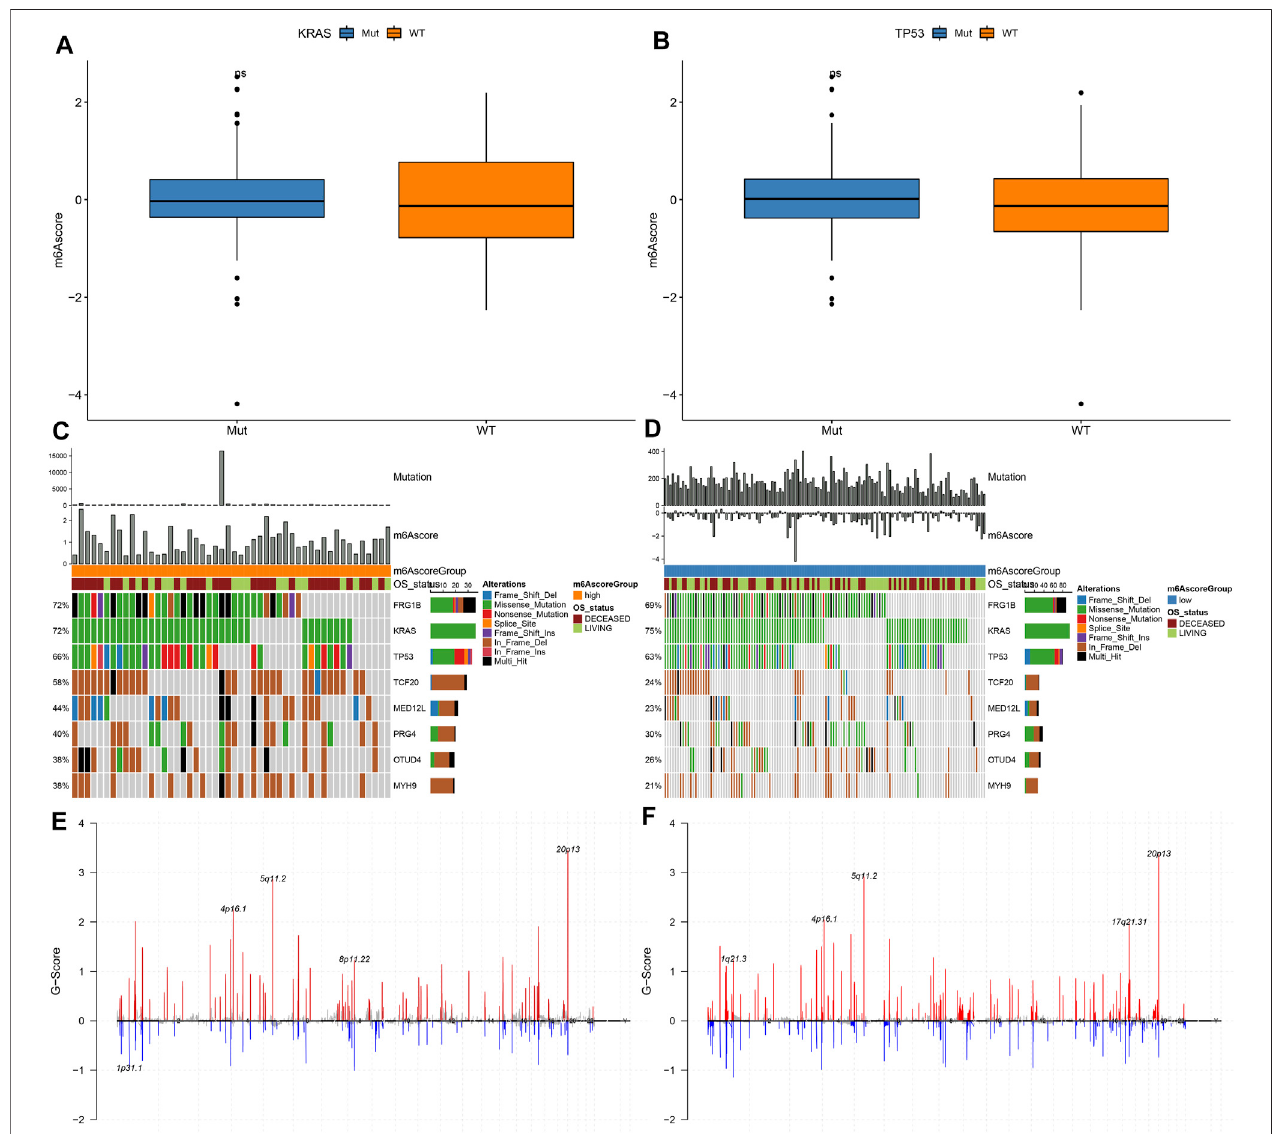
FIGURE 7 | Genetic mutations of samples with high and low m 6 A scores. (A) Distribution of KRAS mutation in high and low m 6 A score groups. (B) Distribution of TP53 mutation in high and low m 6 A score groups. (C,D) The somatic mutation landscape of samples with high and low m 6 A scores. (E,F) The CNV landscape of samples with high and low m 6 A